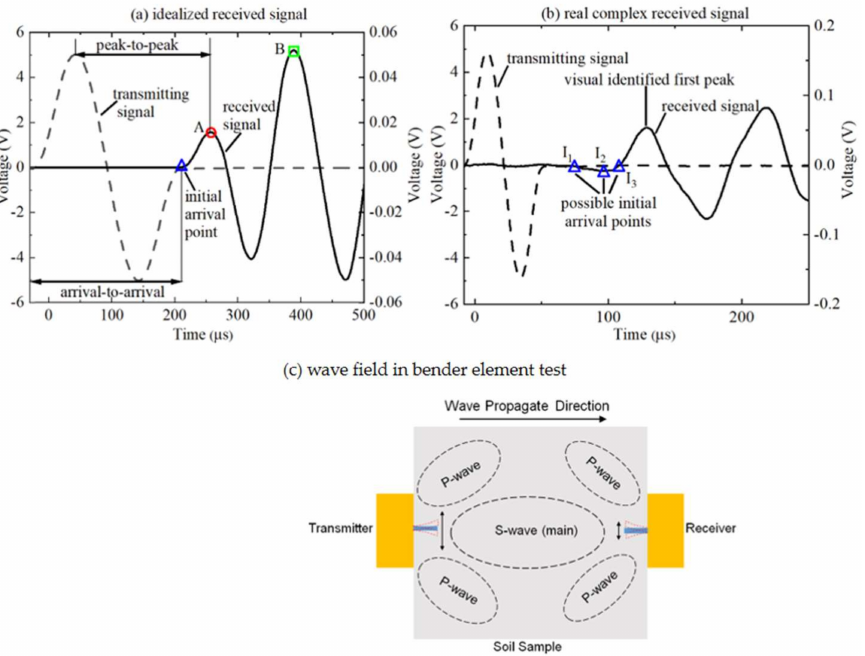
Figure 1. Time domain methods illustrated by ( a ) idealized received waveform, ( b ) real complex received waveform, and ( c ) wave field in bender element